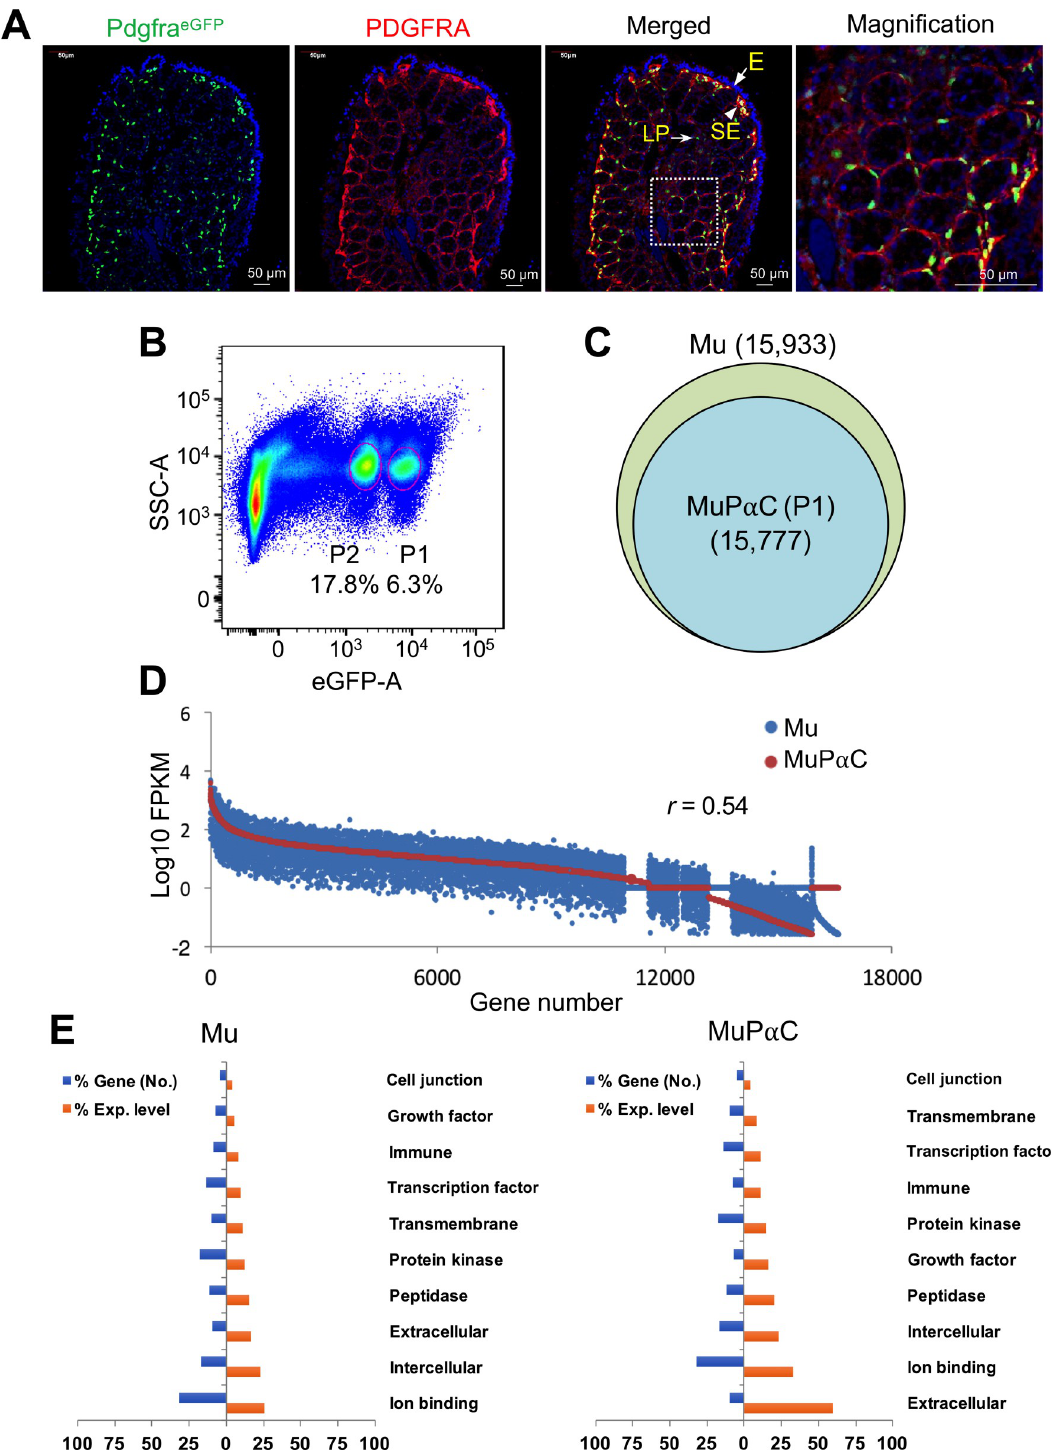
Fig 1. Identification of colonic mucosal subepithelial PDGFR α + (MuP α C) cells and analysis of their transcriptome. A : PDGFR α + cells in the colonic mucosa identified with Pdgfra-eGFP and through PDGFRA antibody. Pdgfra-eGFP mice express the H2B-eGFP (nuclear eGFP) fusion gene from the Pdgfra locus. L, lumen; SE, subepithelium; E, epithelium; LP, lamina propria. B : Primary eGFP + PDGFR α + populations (bright, P1, MuP α C, and dim, P2, MuP α C) from colonic mucosa identified (circled) through flow cytometry. C : Chart showing the number of genes identified in colonic mucosal tissue (Mu) and MuP α C cells in the colonic